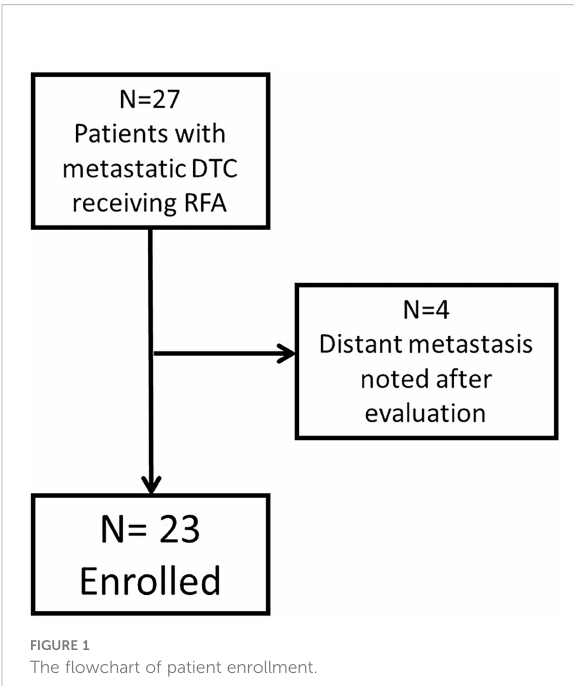
FIGURE 1 The fl owchart of patient